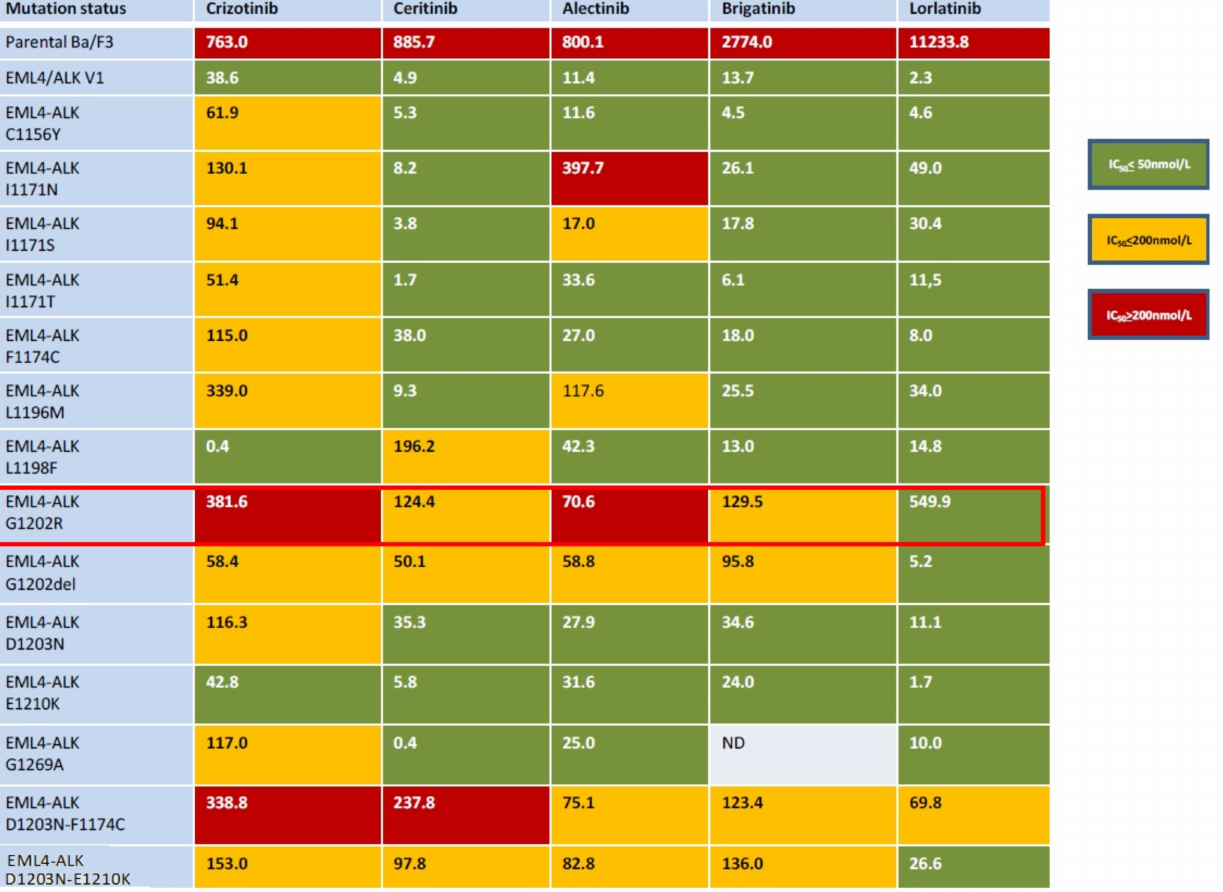
Figure 3. ALK inhibitors have different resistance profiles: highlighted in red is the efficacy of several ALK TKIs against the aggressive resistance mutation G1202R; in vitro data (modified from